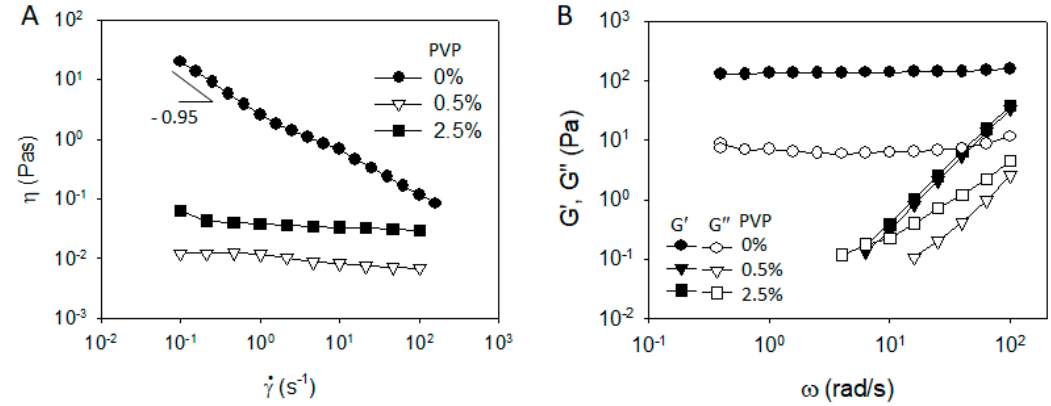
Figure 2. ( A ) Steady shear viscosity and ( B ) frequency dependent storage and loss modulus of CB/Polyvinylpyrrolidone (PVP)/NMP mixtures of 3 wt% (=1.3 vol%) of CB with a varying polymer concentration.